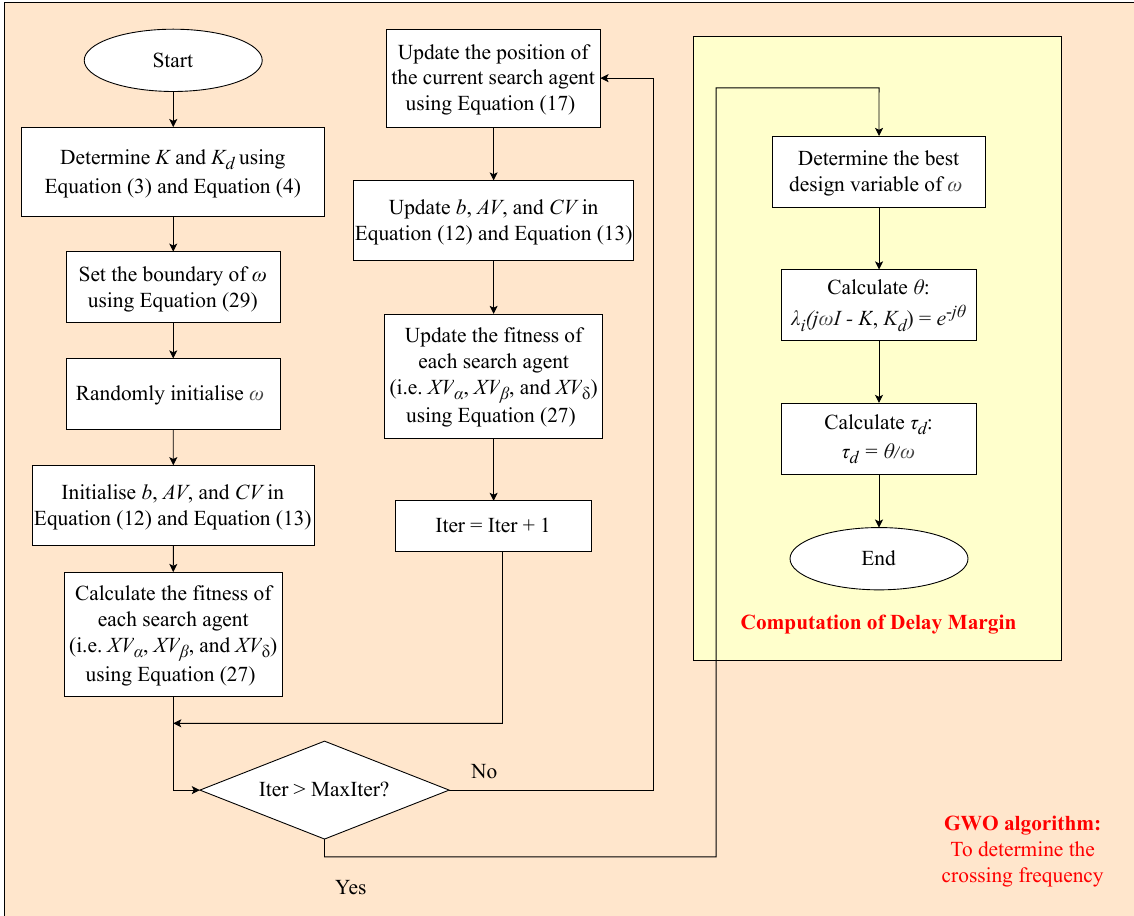
Figure 2. Flowchart of the proposed DM computation based on